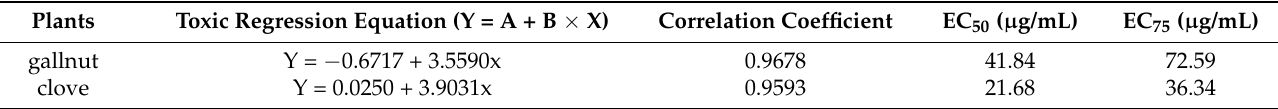
Table 3. Toxic regression equations of ethanol extracts from two plants to R. solani . Plants Toxic Regression Equation (Y = A + B × X) Correlation Coefficient EC 50 ( µ g/mL) EC 75 ( µ g/mL) gallnut Y = − 0.6717 + 3.5590x